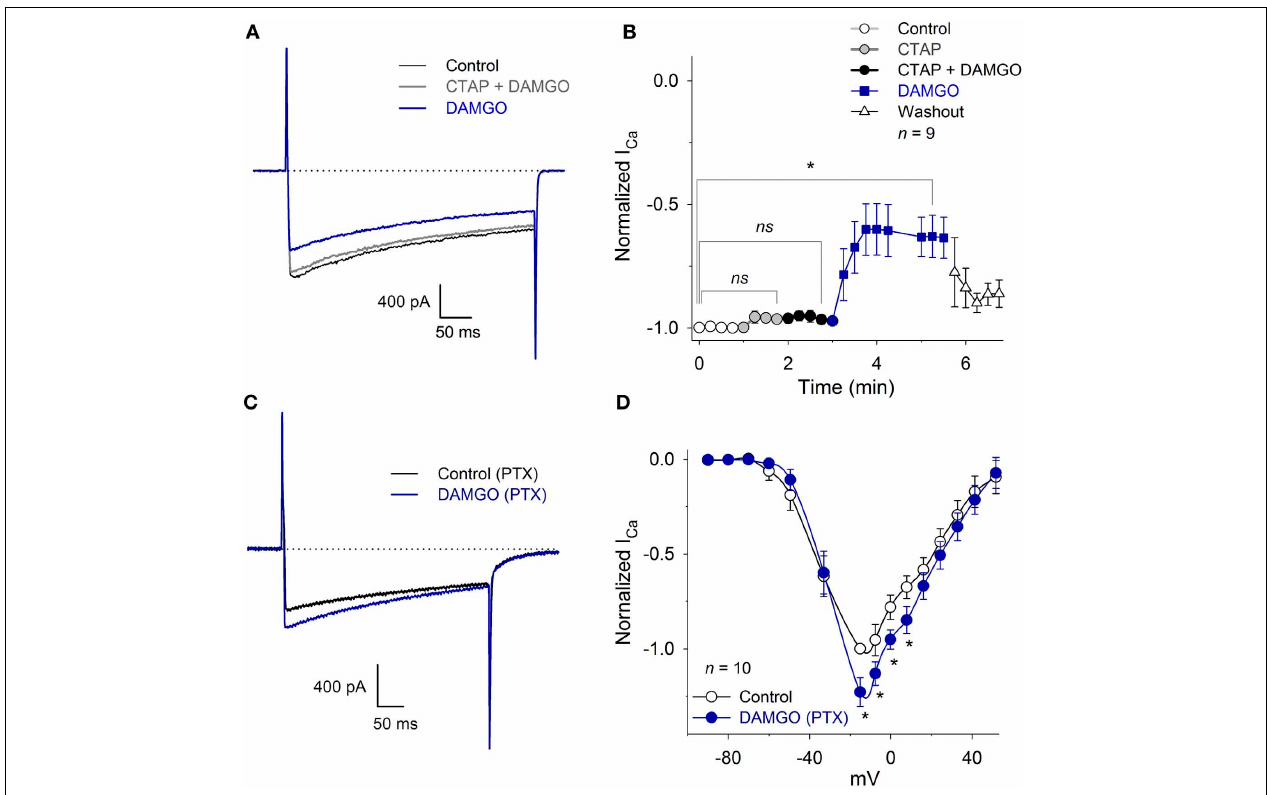
FIGURE 5 | CTAP and PTX occluded the inhibition of the I Ca produced by MOR activation. (A) Representative traces of the I Ca under control conditions, 10 μ M CTAP plus 1 μ M DAMGO and 1 μ M DAMGO. The CTAP had no action when applied alone, but occluded the inhibitory effect of DAMGO. In this and in the following graphs, the dotted line corresponds to zero current. (B) The perfusion of 10 μ M CTAP did not modify the I Ca amplitude. Co-application of CTAP and 1 μ M DAMGO occluded the inhibitory effect of DAMGO, while the subsequent washout of CTAP allowed for